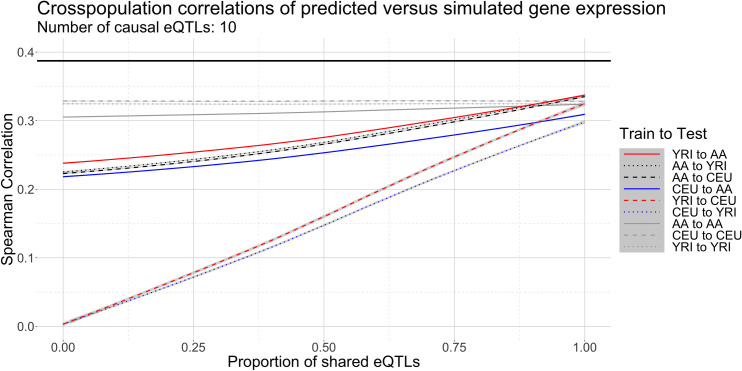
Correlations between predictions and simulated gene expression measurements from simulated populations across various proportions of shared eQTL architecture with 10 causal cis-eQTLs.Here YRI is simulated from the 1000 Genomes Yoruba, CEU is simulated from the Utahns, and AA is constructed from YRI and CEU. The black line represents the upper bound of correlation 0.387 dictated by our choice h2 = 0.15 for the genetic heritability of expression. Each trend line represents an interpolation of correlation versus shared eQTL proportion. Gray areas denote 95% confidence regions of LOESS-smoothed mean correlations conditional on the proportion of shared eQTLs.